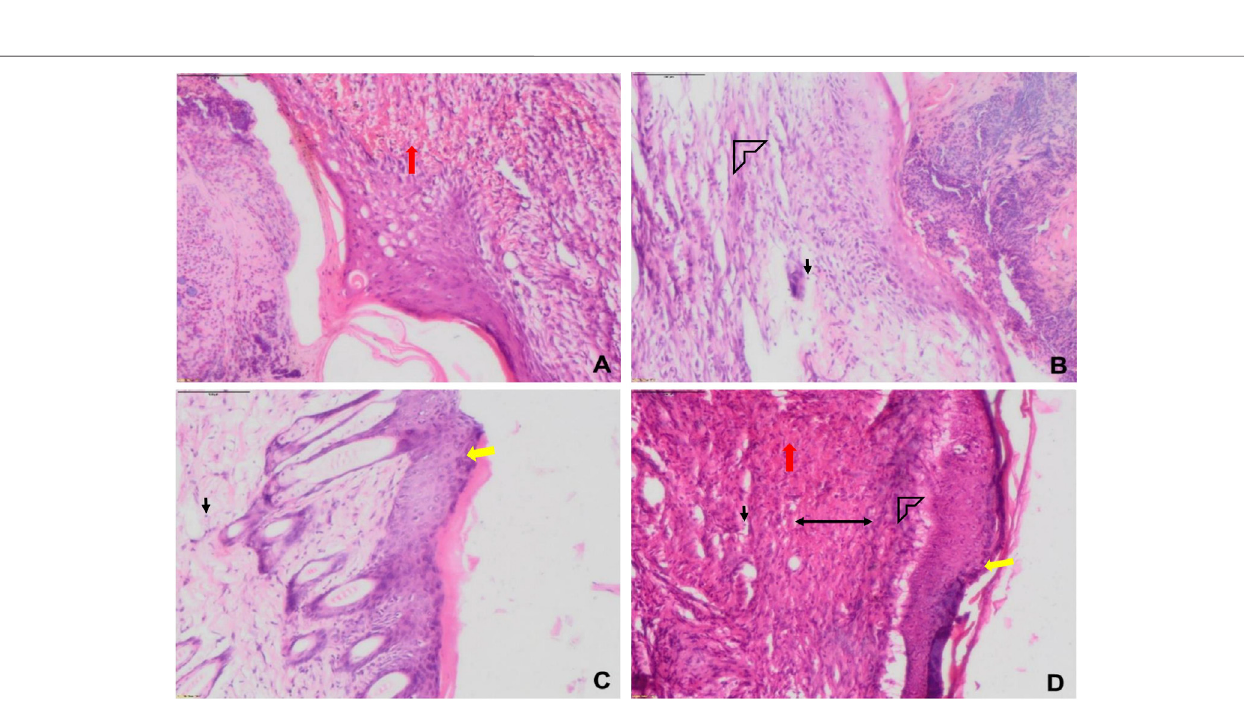
Frontiers in Pharmacology |